Question: Sum up the contents of this chart in one sentence.
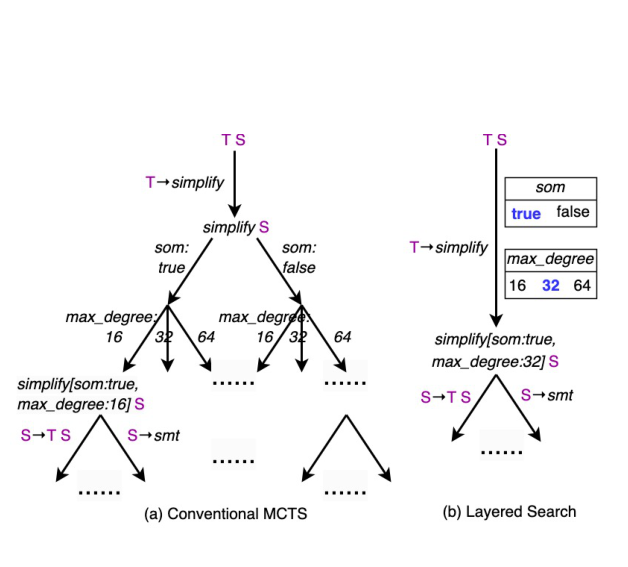
Answer: Comparison of the conventional MCTS and the layer- search in treating tactic parameter tuning